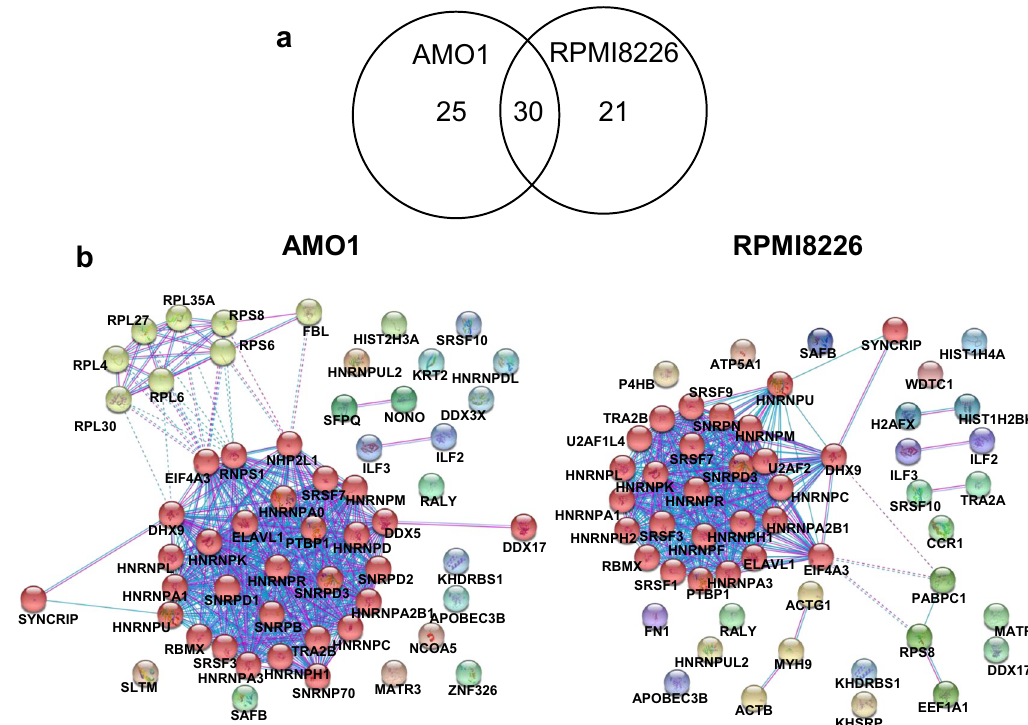
Figure 1. Analysis of the A3B-FLAG interactome in multiple myeloma cell lines. ( a ) Venn diagram of the proteins identified in MS analysis. We identified 55 interacting protein candidates in AMO1 and 51 candidates in RPMI8226 cells. As shown in Supplementary Table 1, 30 protein candidates were identified in both datasets. ( b ) Analysis based on the STRING interaction database showing the putative A3B-interacting proteins identified by MS clustered largely into ribonucleoprotein complexes ( left , AMO1, right , RPMI8226).